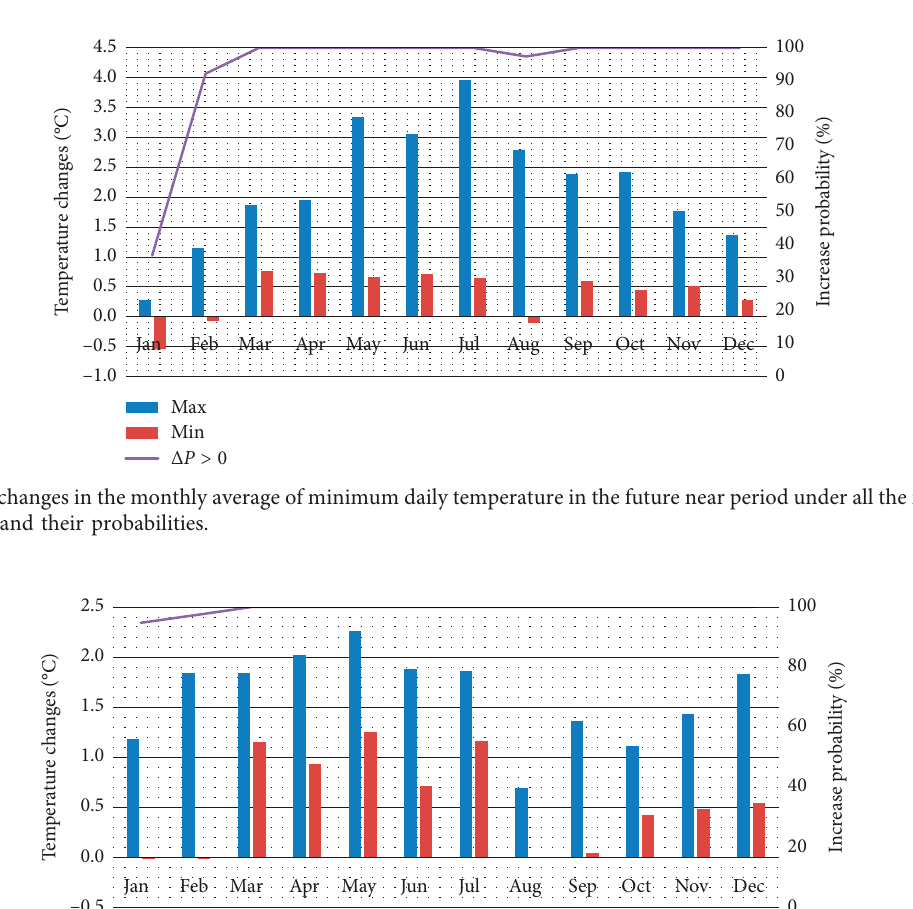
Figure 5: Range of changes in the monthly rainfall in the future near period under all the models and the three emission scenarios and their probabilities.